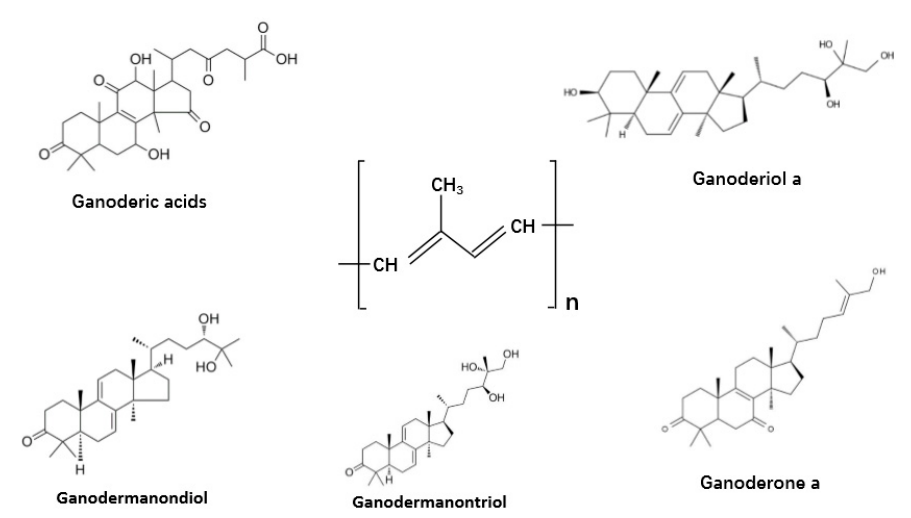
Figure 6. The structures of representative terpenes and terpenoids in the fungus Ganoderma lucidum and Ganoderma lingzhi.